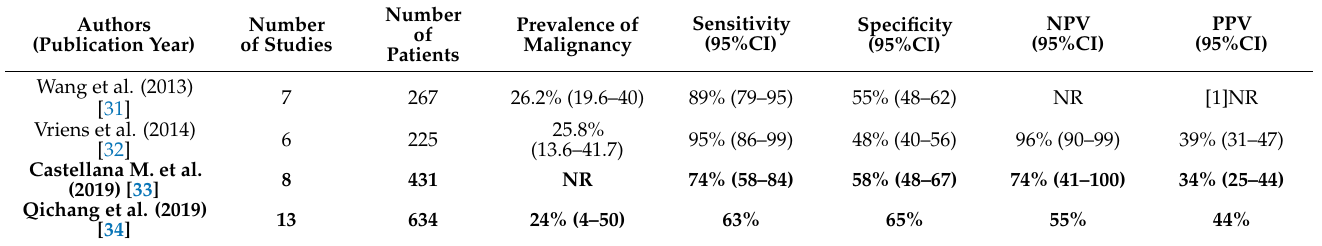
Table 2. The ability of 18 F FDG PET/CT to detect thyroid malignancy in patients with indeterminate thyroid nodules (adapted from Piccardo A et al. Rev Endocr Metab Disord. 2019) [21].